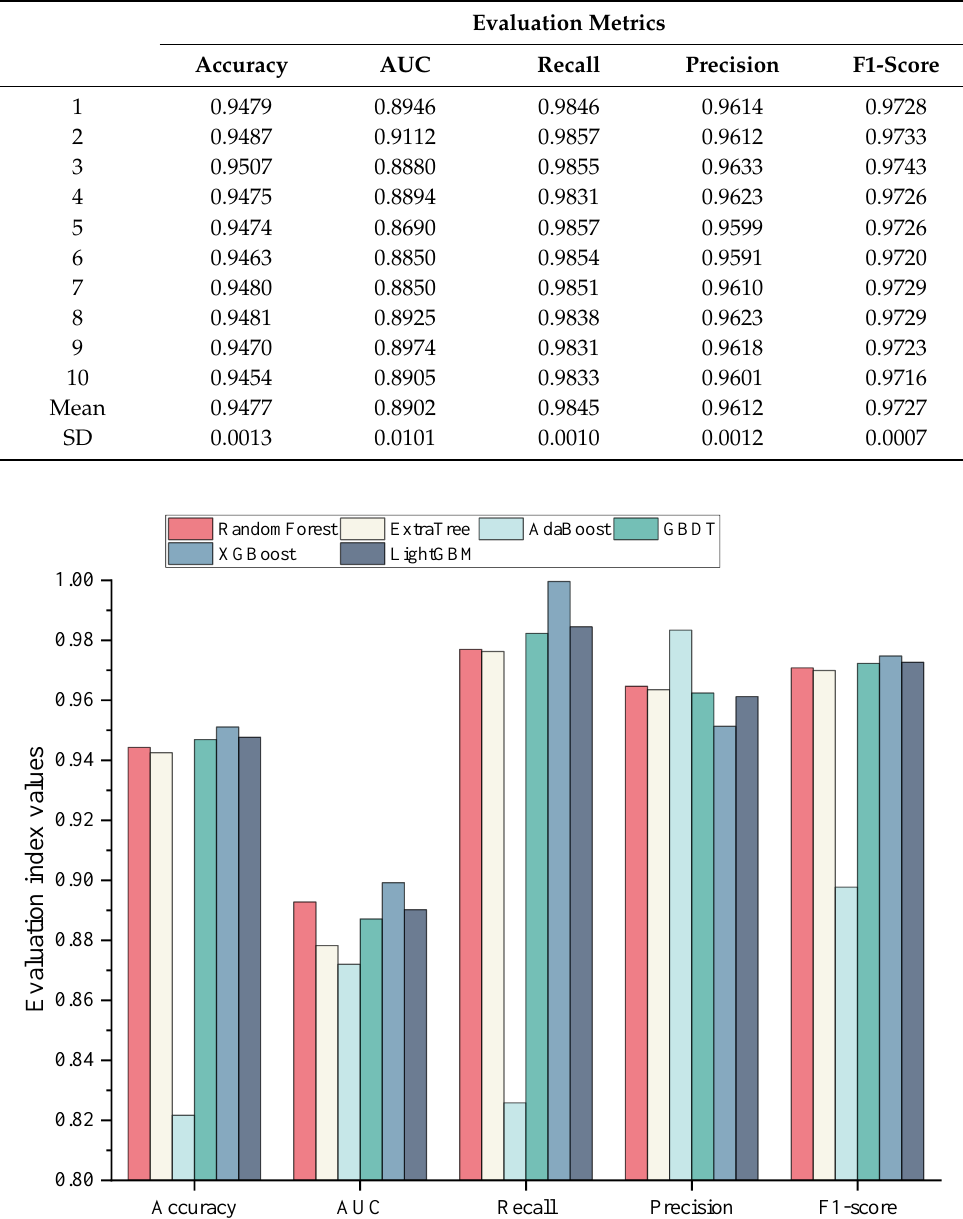
Figure 3. Evaluation results of the ensemble learning models on the training set.